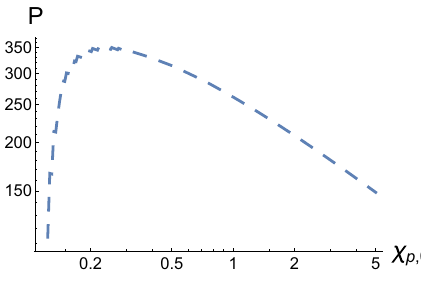
Fig. 11 The scalar yield, P + is plotted as a function of χ p , 0 for δ = 0 in a Gaussian